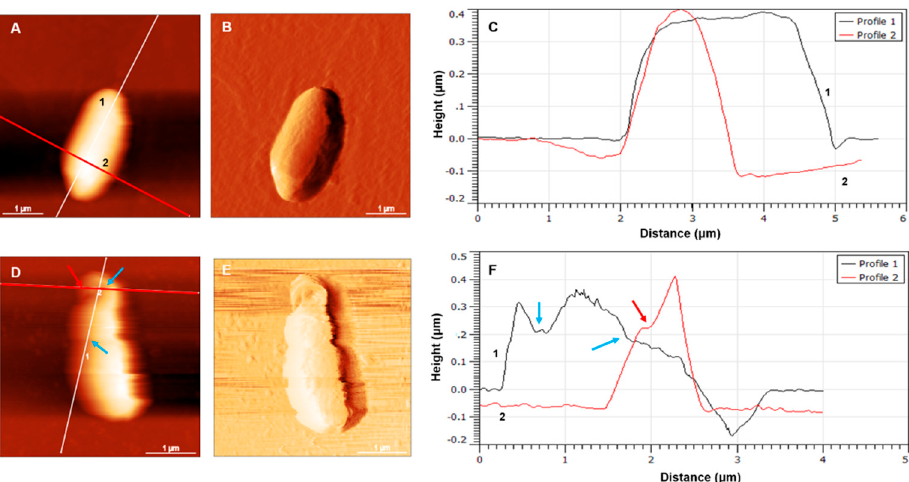
Figure 4. Topography of E. coli HB101 before ( A – C ) and after C 14 -KYR treatment ( D – F ). Upon the treatment of C 14 -KYR, the cell dimension became smaller due to cell shrinkage. Cell debris has accumulated at the border of the cell ( D , E ). Cross-sections of cells before and after treatment were observed, as well as variation in the cellular profile (right of C , F ). The arrows in F indicate a major groove within the damaged cell. The cell height (h) was acquired from the analysis of a surface cell in the absence and presence of C 14 -KYR. Roughness (Ra) was measured from a 100 nm × 100 nm area on the cell surface from five different positions of each topography image. AFM images in 5 µm × 5 µm were performed using a silicon nitride cantilevers with a spring constant of ~0.12–0.14 N/m, a resonant frequency of 5 kHz, and a scanning speed 0.5 Hz.